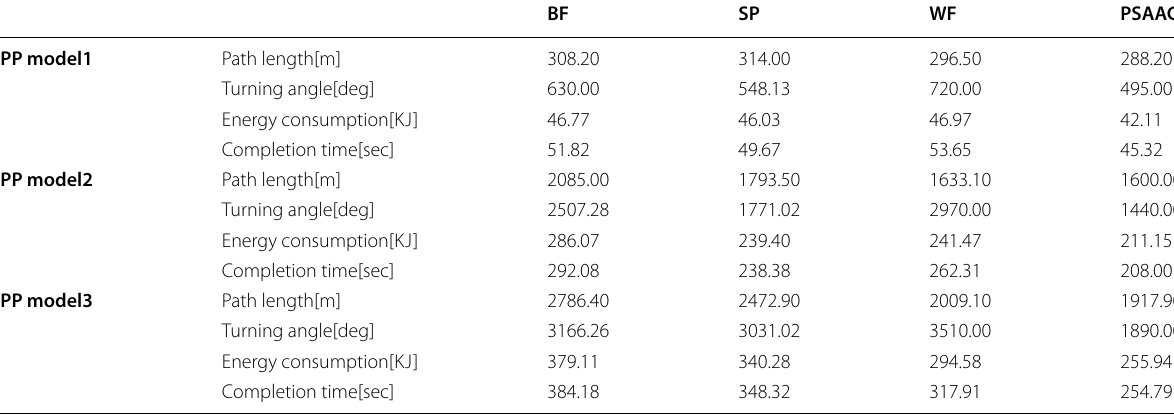
Table 8 Experiments for Performance Comparison between PSAACO and Other Algorithms